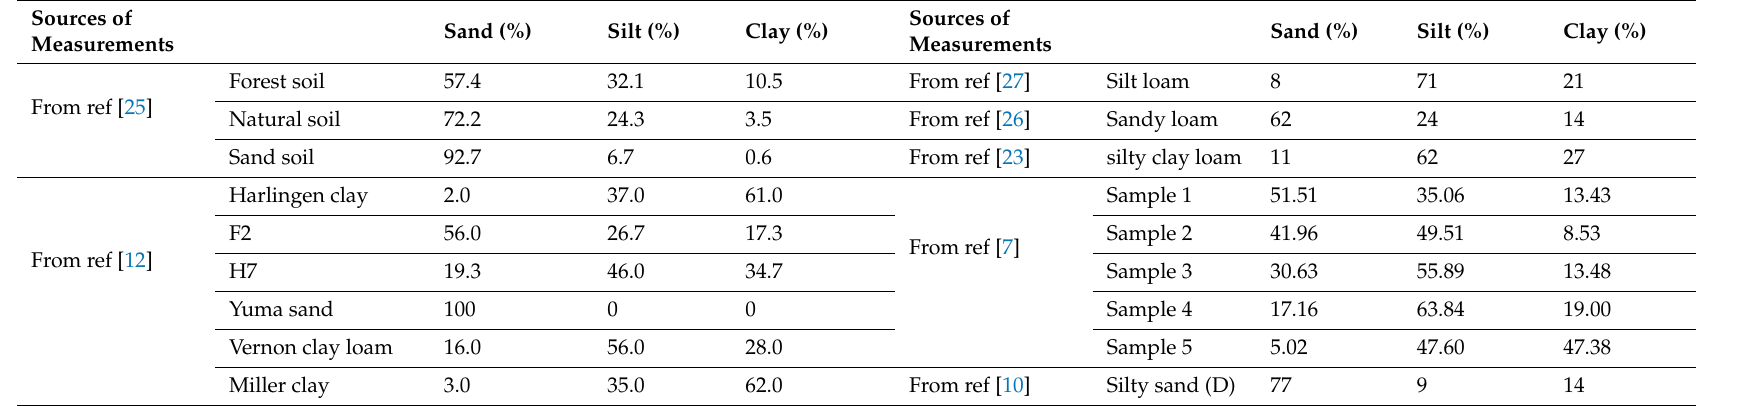
Table 1. Soil texture cases of the existing